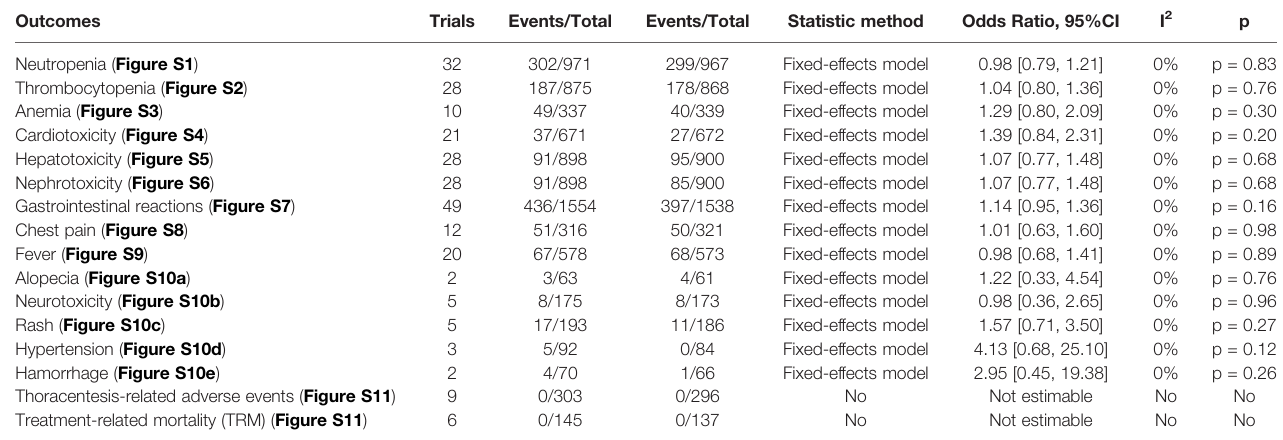
TABLE 2 | Meta-analysis results of ADRs and TRAEs ( Figures S1 – S11